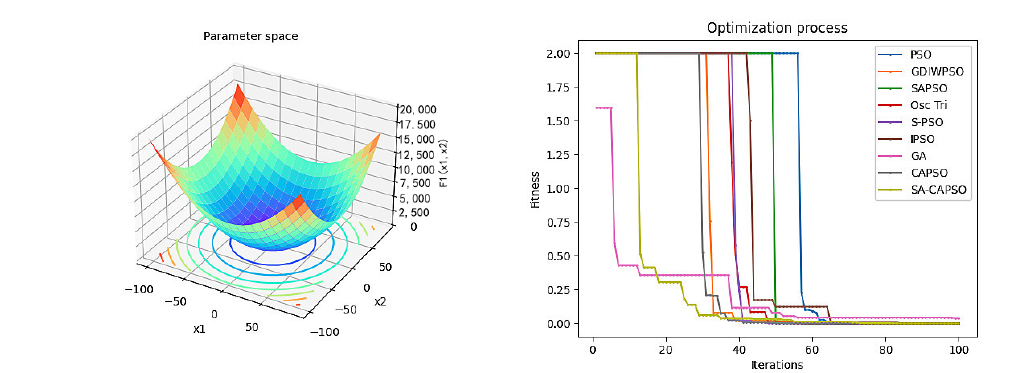
Figure 4. Two-dimensional function image and iterative curve of function